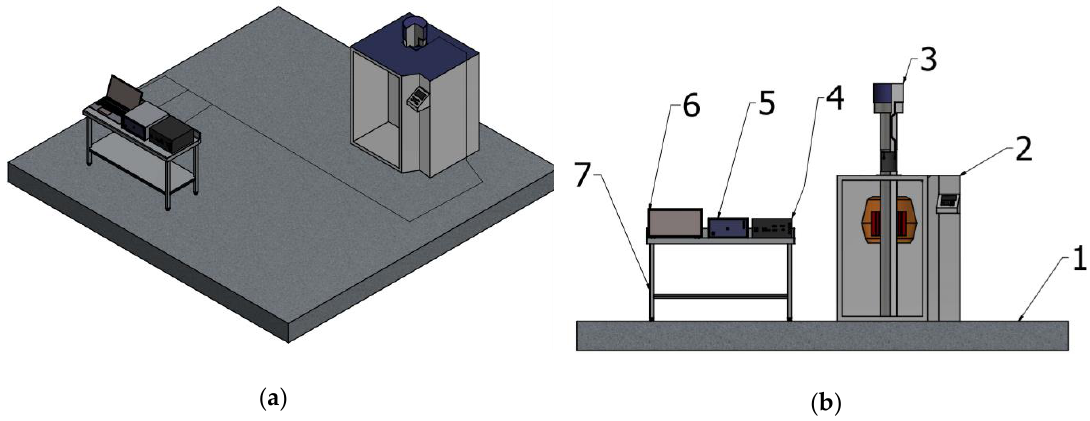
Figure 2. Schematic of the irradiation and measurement setup based on the GC-5000: ( a ) Overall view; ( b ) Detailed view; 1. Ground, 2. GC-5000, 3. Irradiation tube, 4. Optical interrogator, 5. OBR, 6. Laptop, 7. Table support.